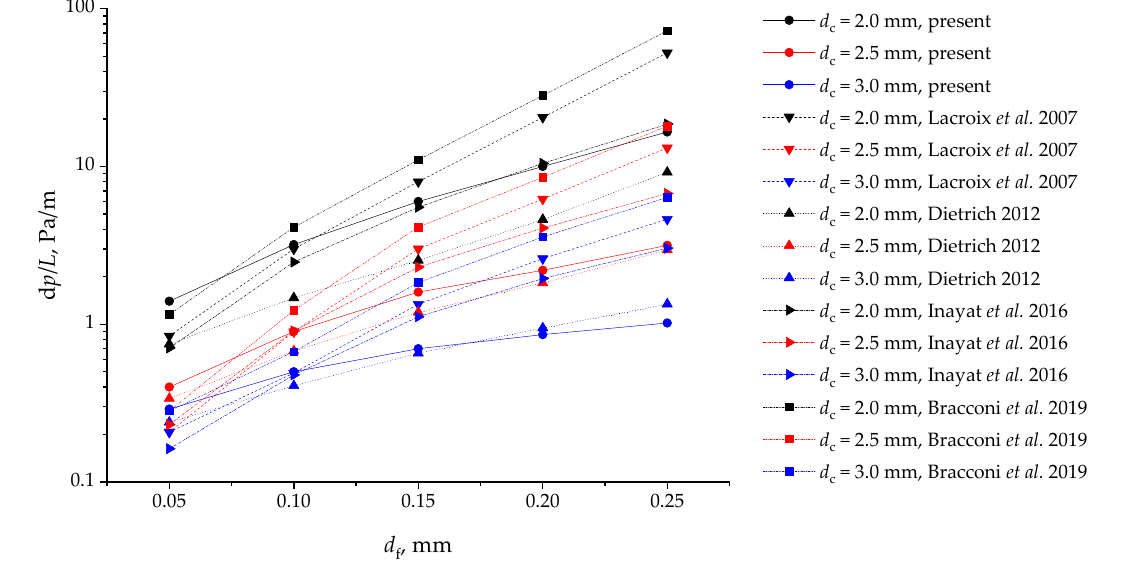
Figure 8. Dependence of the pressure drop on the geometric parameters of the cell. Comparison of the results of these studies with the results of literary correlations [37,50–52].